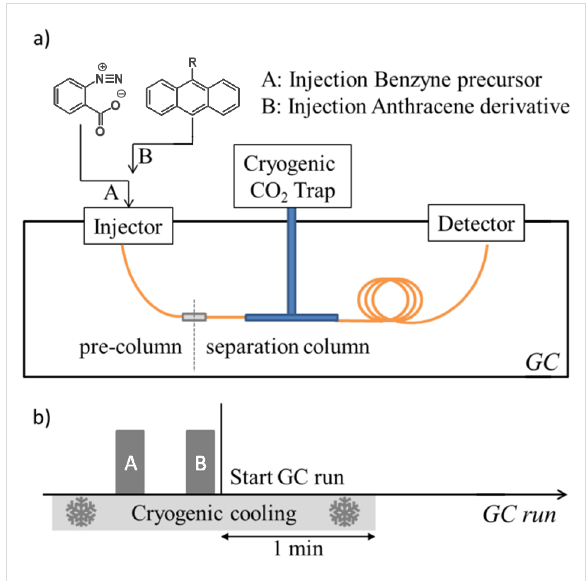
Figure 2: The experimental setup and a) the injection sequence protocol of the cryogenic ocRGC measurements b). Conditions: on-column cold injection, 60 °C for 5 min, then 6 °C/min to 180 °C, 120 kPa He; pre-column: fused silica, 10 cm, 250 nm film